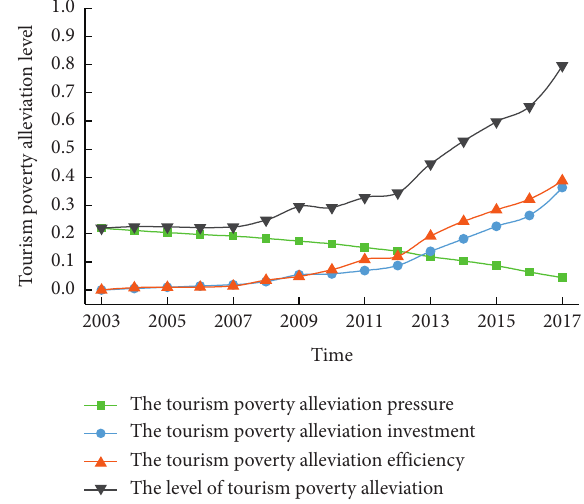
Figure 3: The evolution process of pro-poor tourism level in